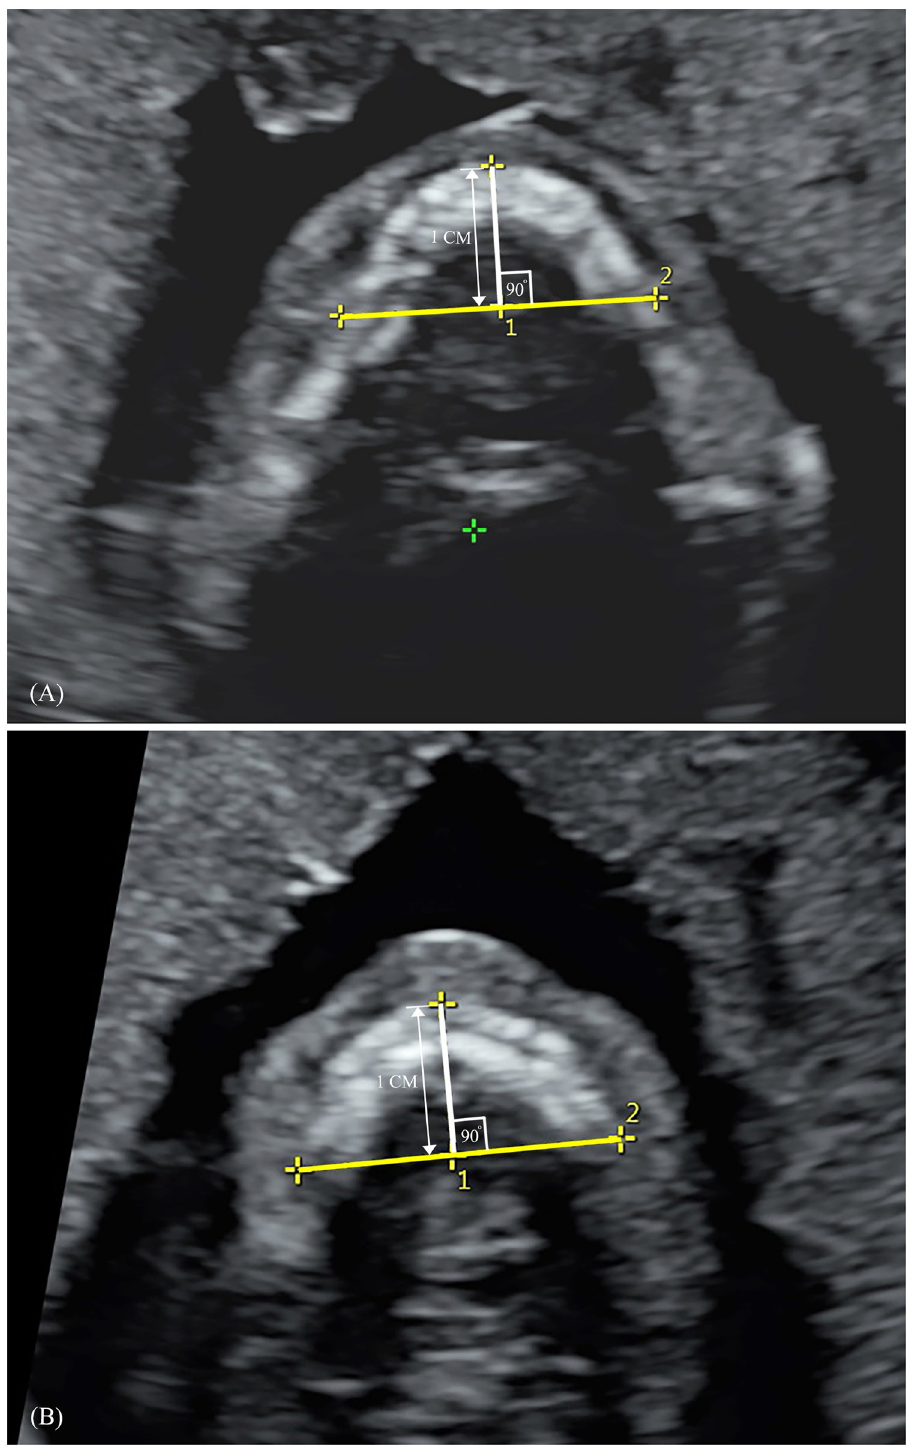
Fig 3. Mandible width and maxilla width measurements. (A) Mandible width (B) Maxilla width.